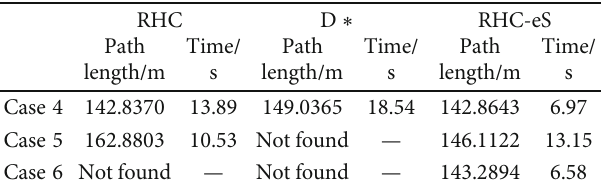
Table 4: Comparison of experimental results in unknown